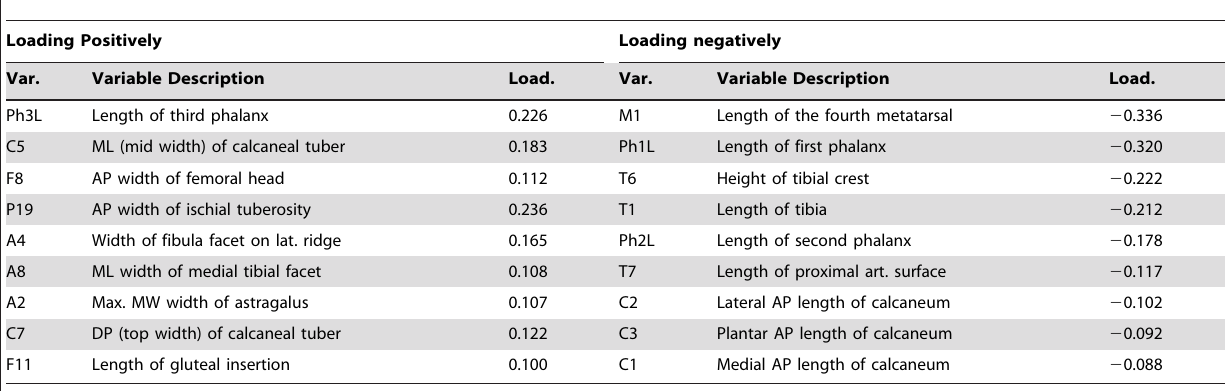
Table 2. Factor loadings for Principal Components Analysis: without the pelvis.